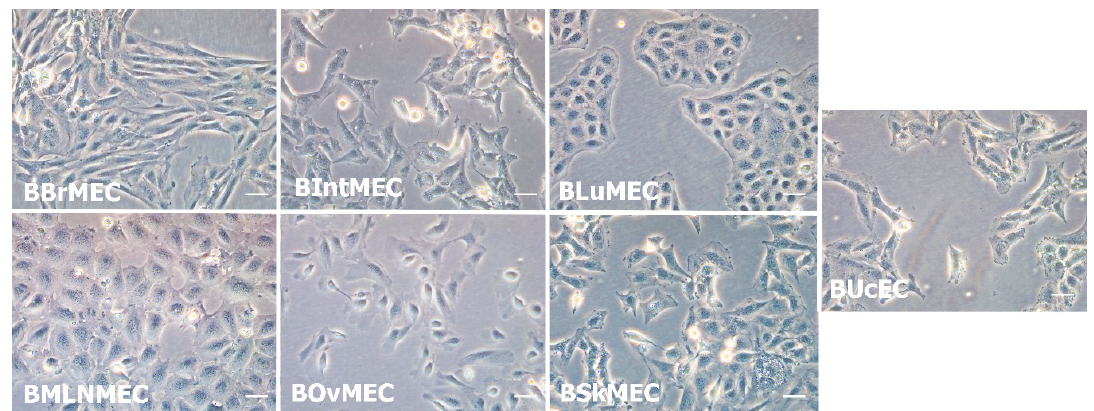
Figure 1. Morphological aspect of the seven established bovine endothelial cell lines. Representative optical microscopy photographs (×20) of endothelial cell lines in culture. Pictures of growing cells were taken using inverted Leica DMi1 microscope equipped with digital camera Leica MC120 HD. Scale bar of 50 μ m.